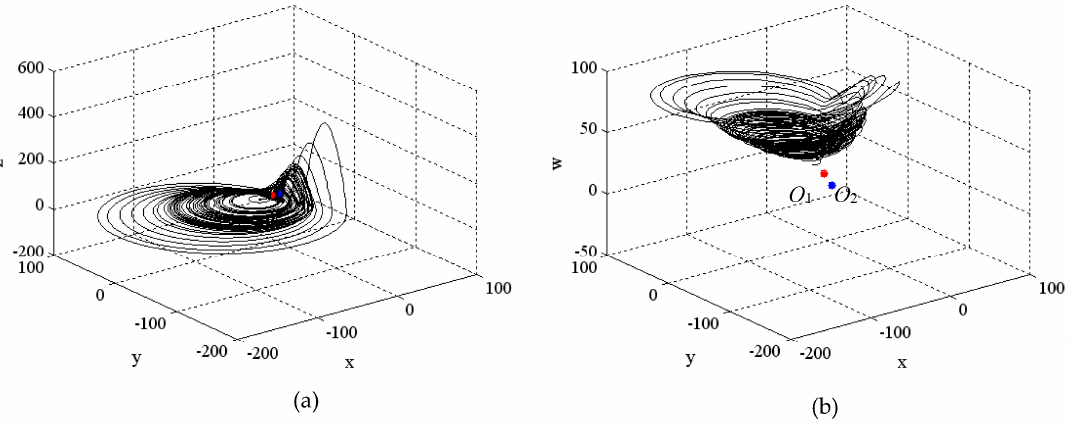
Figure 3. Phase space of system (2) in hyperchaotic regime, when ( a , b ) a = 0.25, b = 3, c = 0.5, d = 0.05, b 1 = 0.2, b 2 = − 0.1, b 3 = b 4 = 0.1. The first equilibrium O 1 is marked with red color and the second equilibrium O 2 is marked with blue